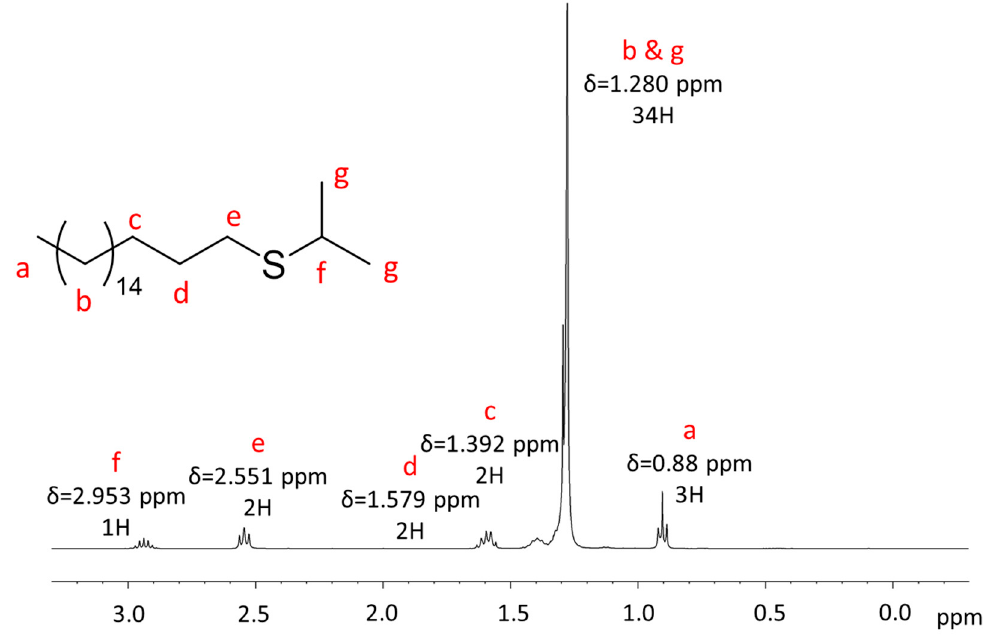
Figure A5. 1 H NMR of isopropylsulfanyloctadecane.